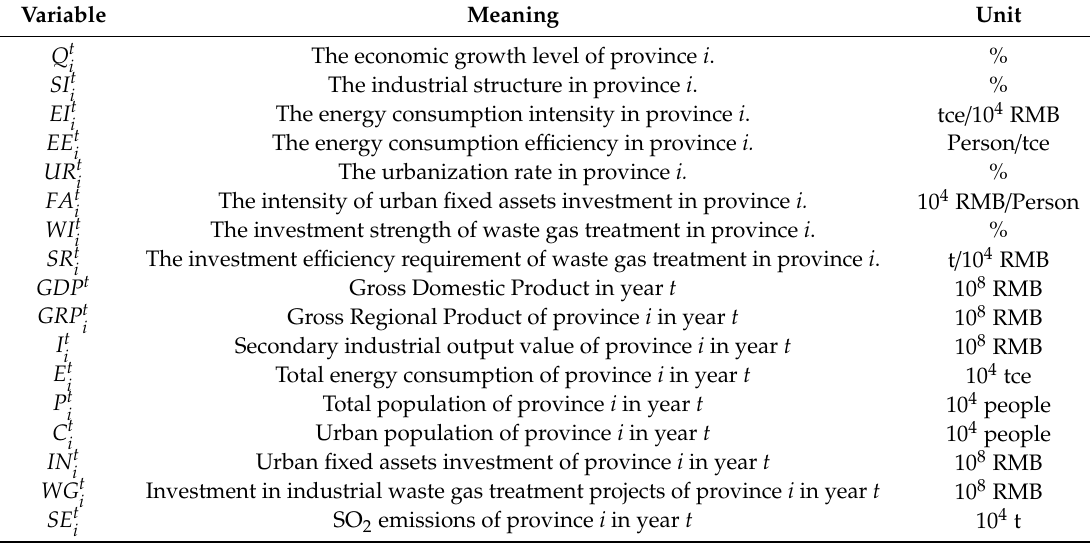
Table 3. Meaning of variables in the generalized logarithmic mean Divisia index (GLMDI)